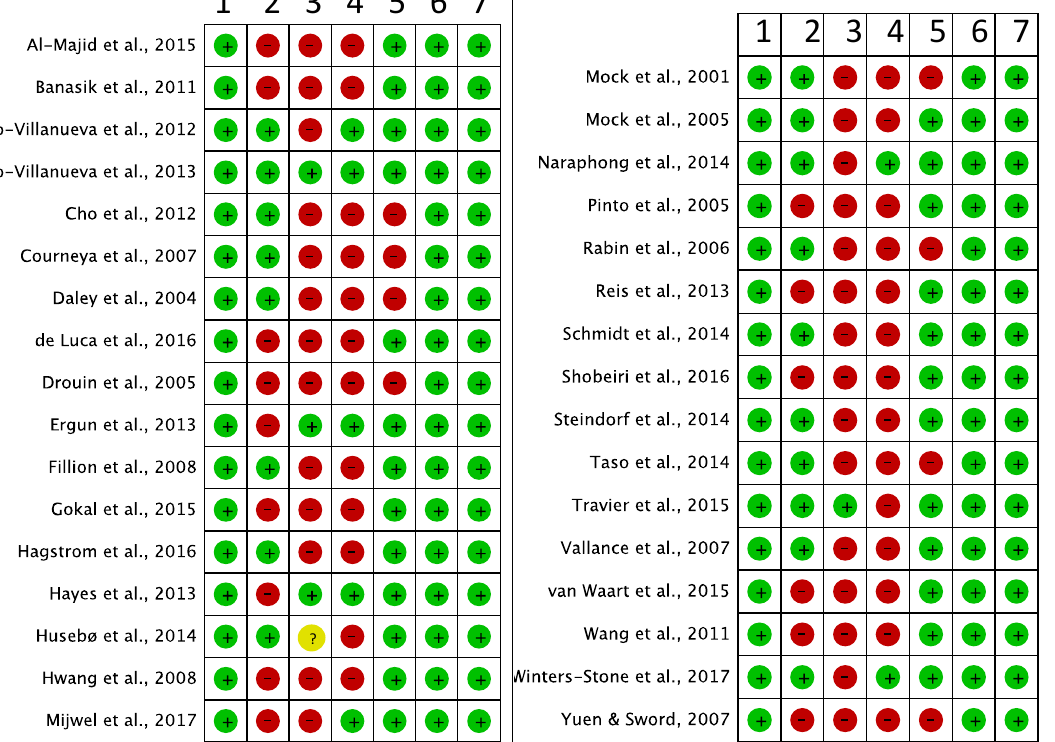
Figure 2. Methodological quality of included studies using the Cochrane “risk of bias assessment tool” [35–65,77,78]. 1: Random sequence generation (selection bias). 2: Allocation concealment (se- lection bias). 3: Blinding of participants and personnel (performance bias). 4: Blinding of outcome assessment (detection bias). 5: Incomplete outcome data (attrition bias). 6: Selective reporting (re- porting bias). 7: Other bias. Green: Low risk. Red: High risk. Yellow: Unclear risk.